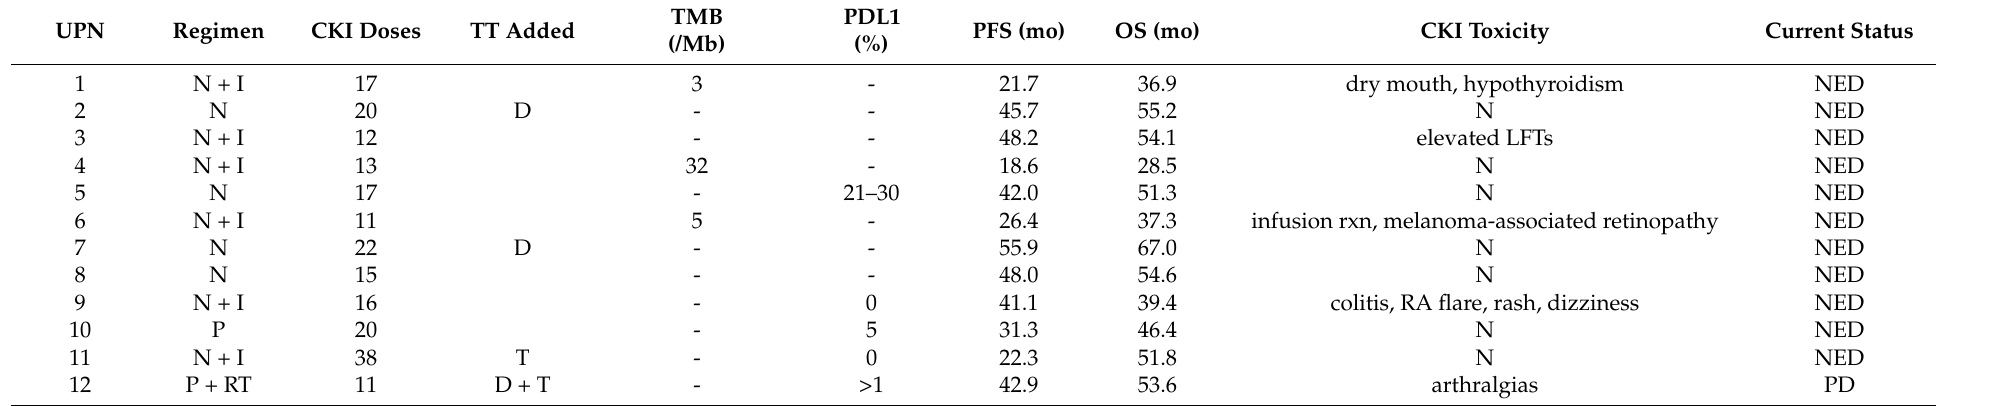
Table 2. Individual clinical outcomes of patients who discontinued